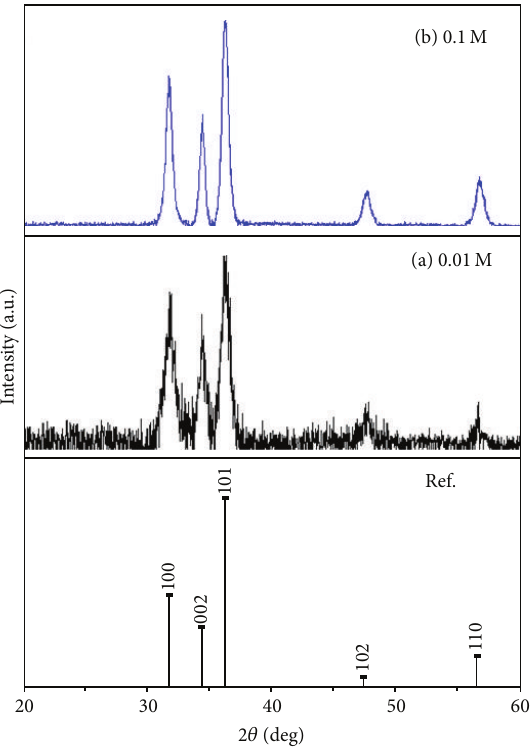
Figure 3: XRD patterns of ZnO nanoparticles at various precursor concentrations. (a) 0.01 M and (b)